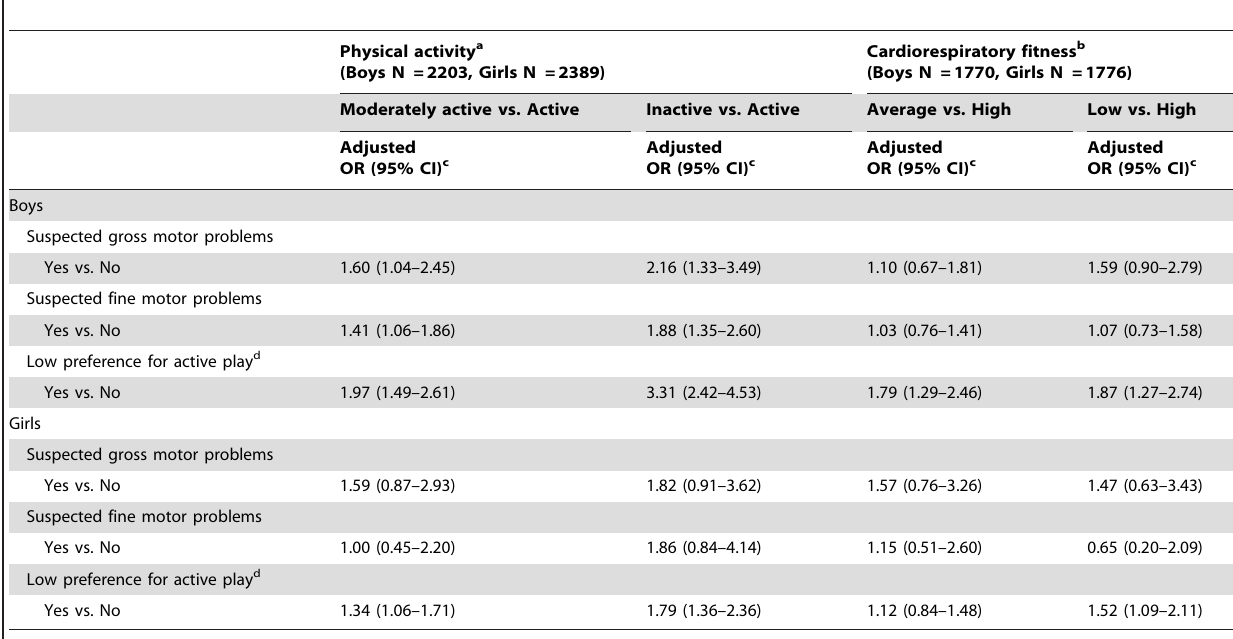
Table 3. Multinomial regression of physical activity and cardiorespiratory fitness at age 16 years on suspected motor problems and low preference for active play at age 8 years.